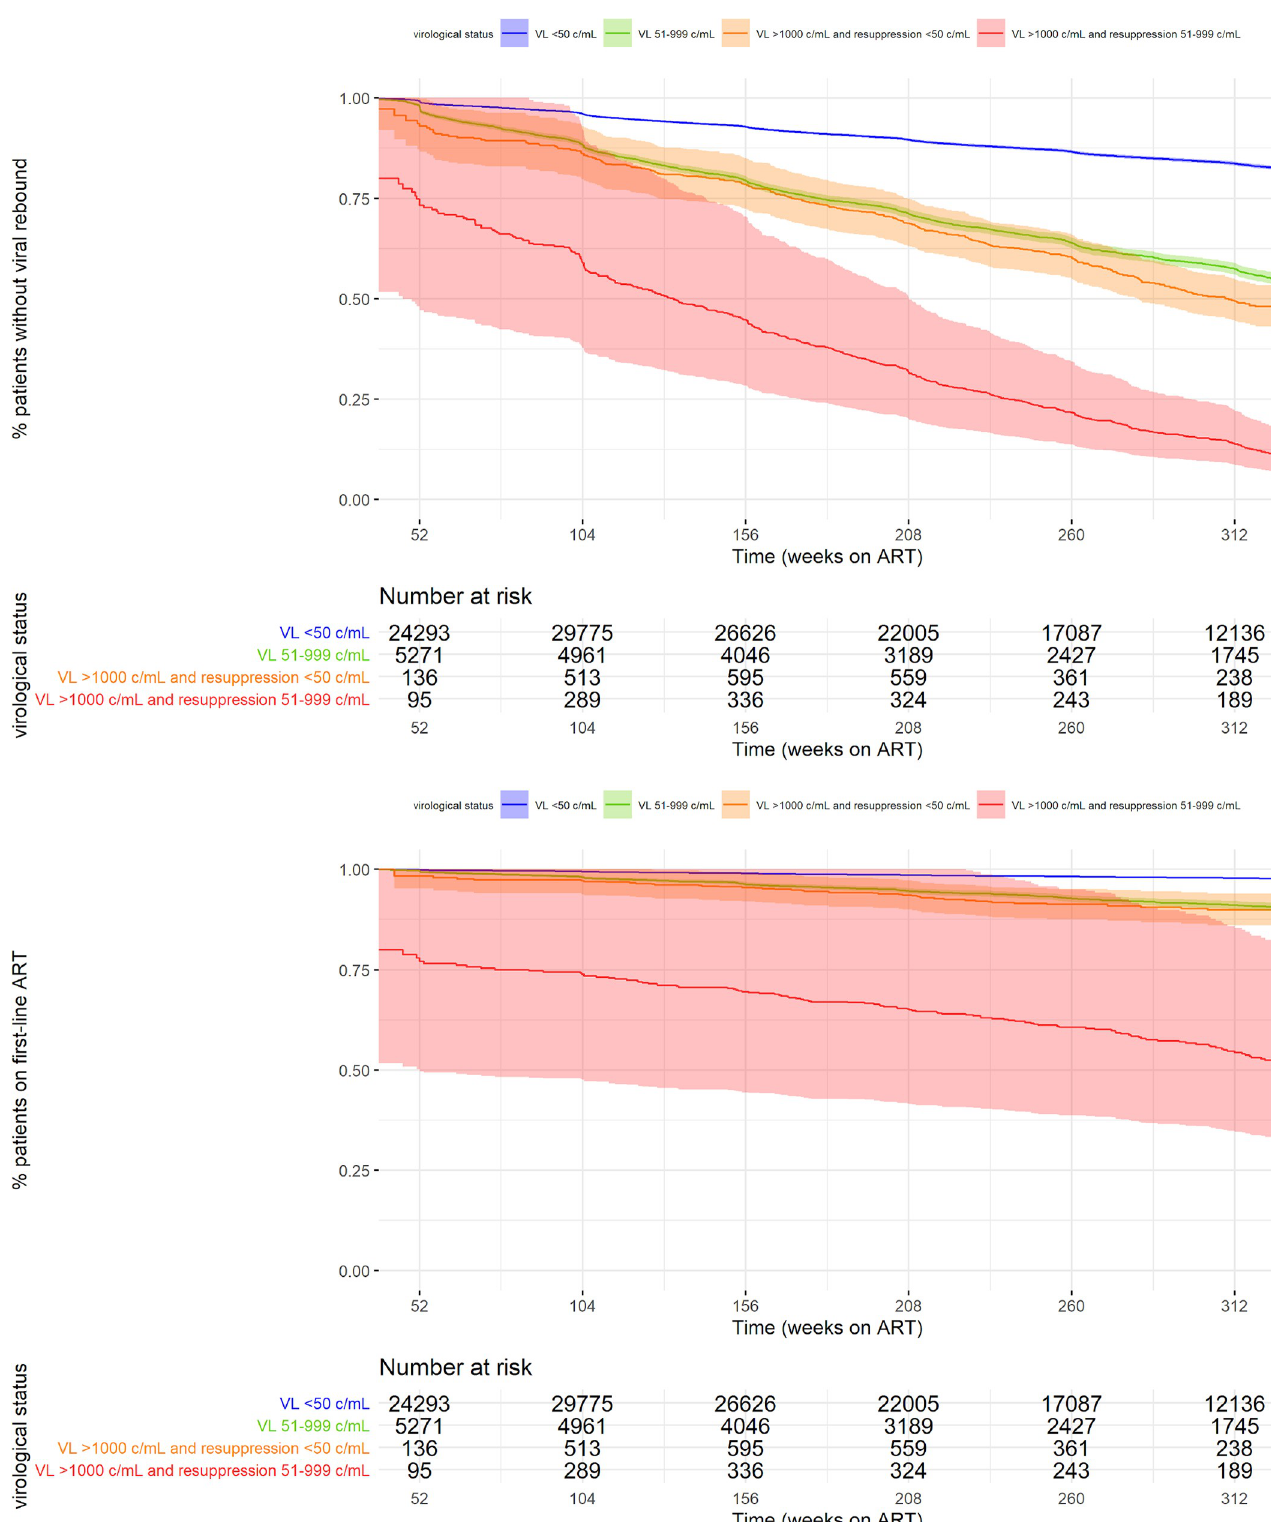
Fig 3. Mixed-models interval survival analysis—Viral rebound and switch to second-line ART. Note: Extended Kaplan-Meier estimators based on interval Cox proportional hazard analysis of 57,006 patients on first-line ART. Of 104,719 patients, exclusion was based on missing baseline CD4 count in 13,101,